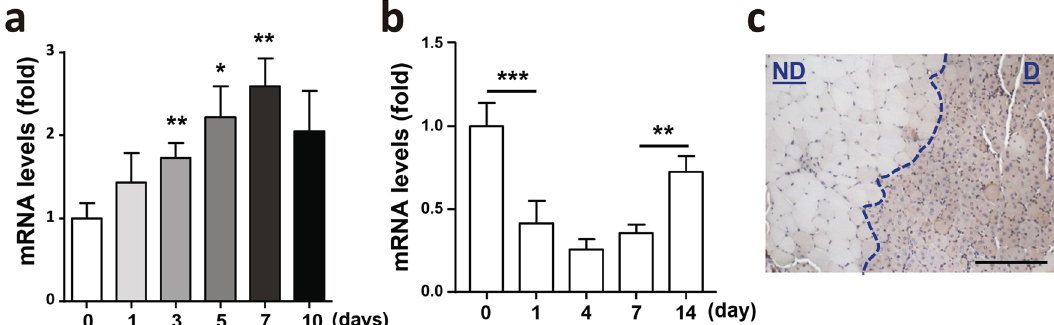
Fig. 1 Rrm2b was upregulated at late stage of regeneration in wild-type skeletal muscle. a After induction of MuSC differentiation in vitro, the Rrm2b mRNA levels were signi fi cantly upregulated at days 3, 5, and 7. b Rrm2b expression levels in the skeletal muscle (gastrocnemius) of 5-month-old F/F mice at days 1, 4, 7, and 14 after damage. The values at day 0 served as the nondamaged controls, and 3 – 5 mice were in each group. c Rrm2b IHC expression in skeletal muscle (femoris) was higher in the damaged region 14 days after BaCl 2 injection. ND, nondamaged region. D, damaged region showing centrally nucleated fi bers. Scale bar, 100 µm. The mice were 3 months old. The results are presented as the mean ± SD. Statistical analysis of differences between the groups was performed by two-tailed, unpaired t-tests, and the P -values were calculated. Asterisks denote statistically signi fi cant changes from the control and are de fi ned as * P < 0.05; ** P <